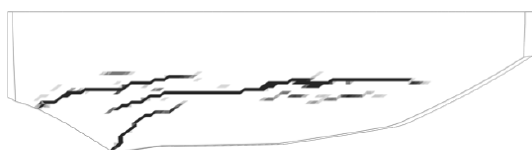
Figure 8. Example of an illustration of the predicted extent of cracking due to static loads from contributor No. 4.